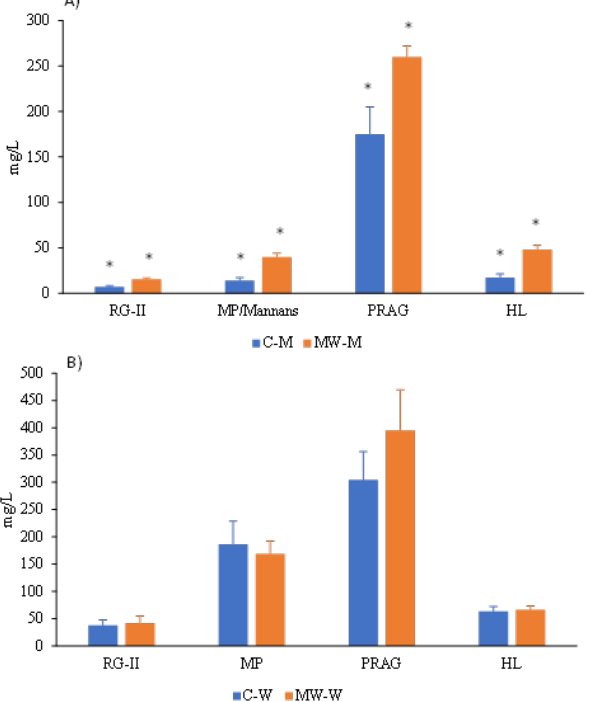
Figure 3. Concentration of rhamnogalacturonan type II (RG-II), mannoproteins (MPs) or mannans, polysaccharides rich in arabinose and galactose (PRAGs), and homogalacturonans (HLs) in musts ( A ). Concentration of rhamnogalacturonan type II (RG-II), mannoproteins (MPs), polysaccharides rich in arabinose and galactose (PRAGs), and homogalacturonans (HLs) in wine ( B ). C-W: control must. MW-W: must from microwave-treated grapes. C-W: control wine. MW-W: wine from microwave-treated grapes. Values with (*) show significant differences according to the t-test ( p < 0.05).